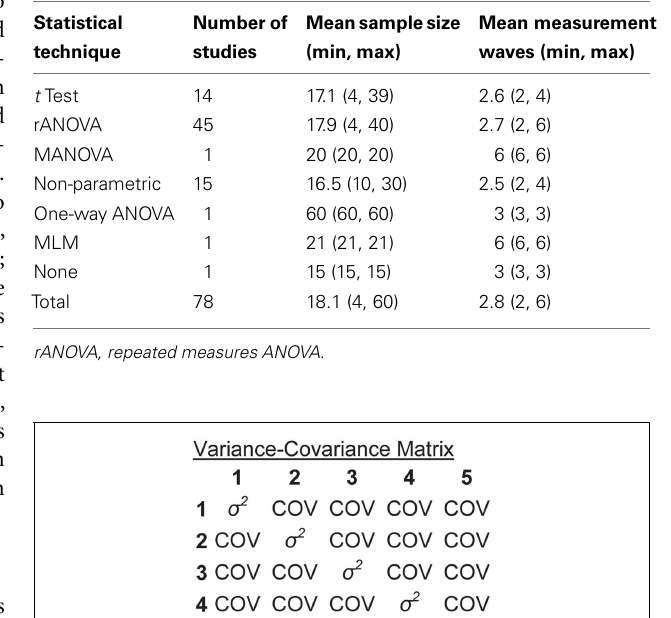
Table 1 | Status of current data analysis in neglect rehabilitation.